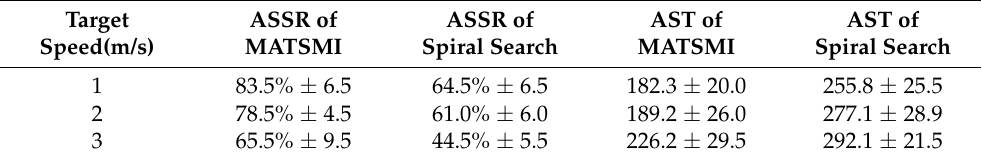
Table 1. ASSR and AST of MATSMI and spiral search methods at different target speeds.